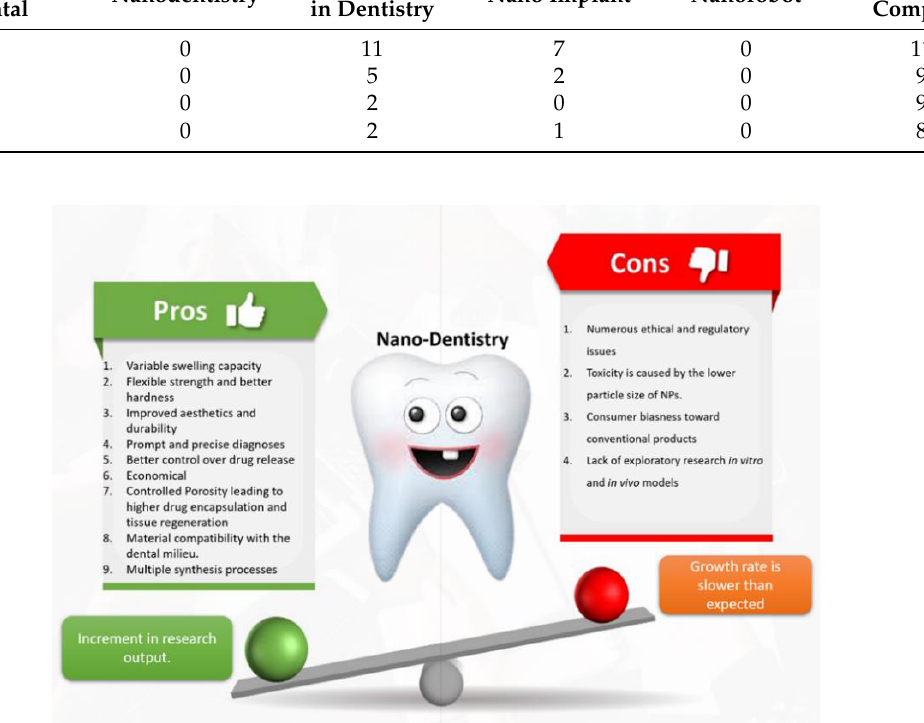
Figure 1. Visual presentation to demonstrate how advantages give thrust to nano dentistry research by tilting the balance towards the pro’s side.